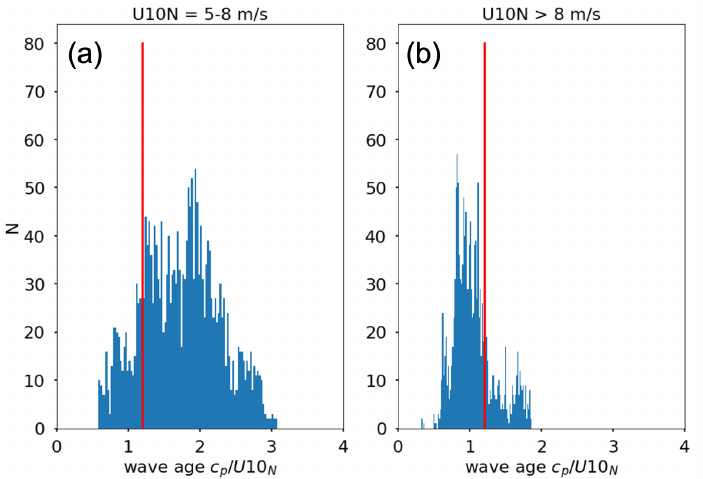
Figure 10. Wave age distribution for wind speeds ranging between 5–8 m/s ( a ) and >8 m/s ( b ). The red line indicates a wave age value of